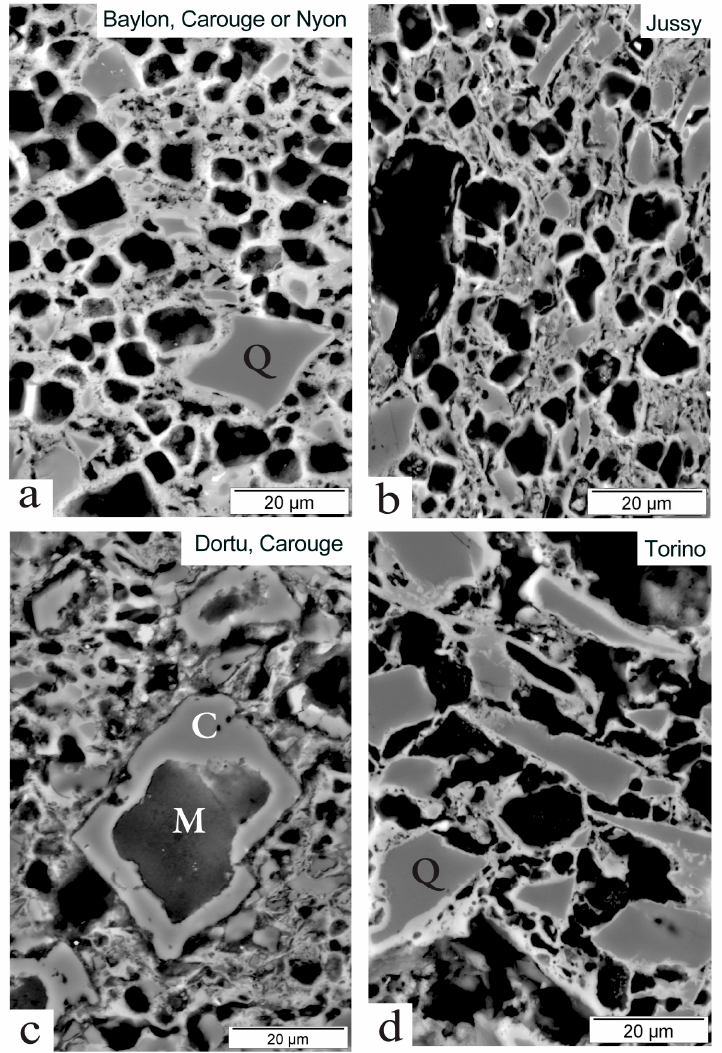
Figure 21. SEM-BSE images of four typical CaO- & MgO-rich samples from Western Switzerland (Carouge, Nyon), France (Jussy) and Italy (Torino) [37]. ( a ) Body type A with angular fragments of quartz (grey, Q), square to rectangular pores (black) and a greyish matrix (Sample CAR 4); ( b ) Body type A (NYO 4); ( c ) This body type B contains large rhombohedral fragments with a MgO-rich core (M) and a CaO-rich border (C); (BER 13); ( d ) Body type A (CAR 8).